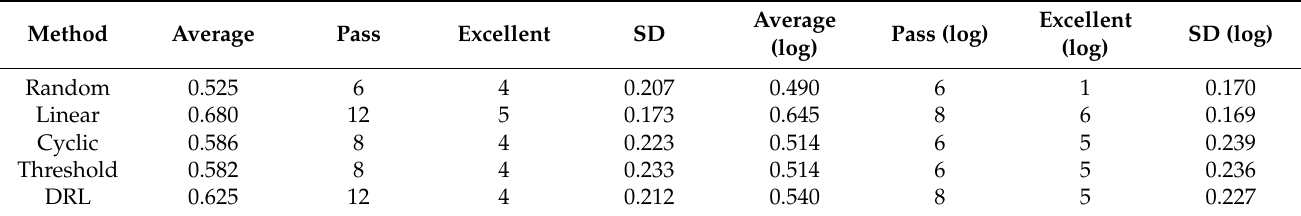
Table 4. The results of HLR that do not consider the knowledge point association.